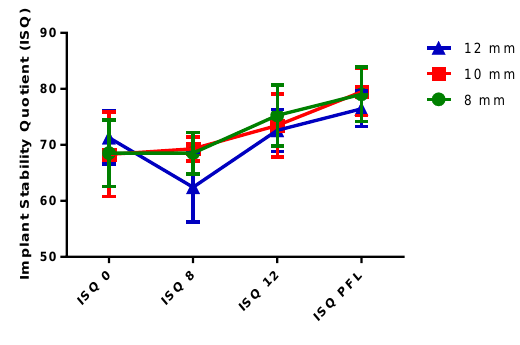
Figure 4: Line graph showing the difference in implant stability throughout the study in relation to DI length Table 3: The differences in implant stability between the maxilla and the mandible Measurement